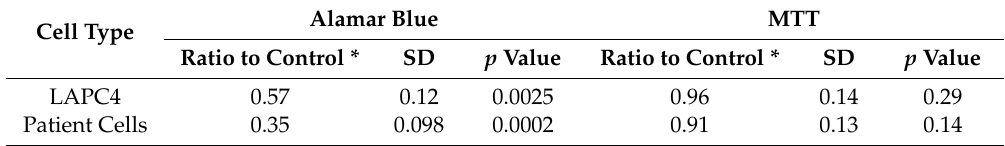
Figure 2. Effect of DOX on LAPC4 metabolic activity and migration. Metabolic activity was significantly decreased with all the drug concentrations tested. There was no effect on LAPC4 proliferation with DOX treatment. Migration ability of LAPC4 cells was significantly decreased with only the higher concentrations of DOX (0.05 and 0.1 µM). Alamar Blue and MTT assays were done as triplicates per trial over four independent experiments. The migration assay was done as triplicates per trial in three independent experiments. Results are shown as mean ± STDEV (** = p < 0.01, *** = p < 0.001, # denotes p = 0.08). Table 1. Comparison of metabolic activity assays of Dox-treated LAPC4 cells.